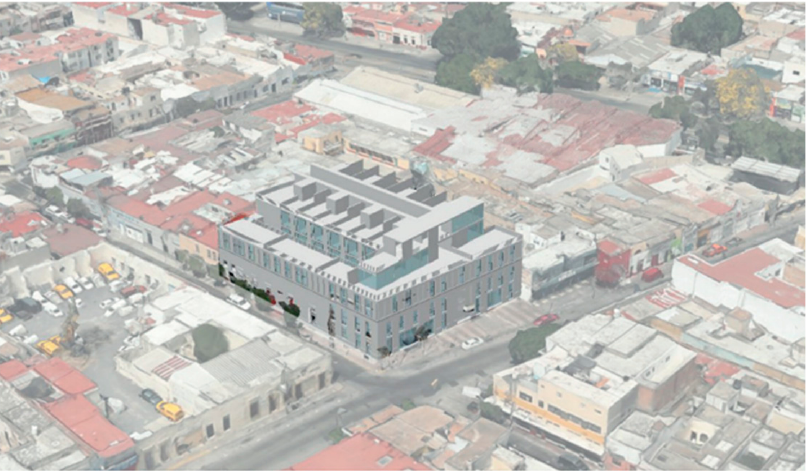
Figure 10. Example of good integration with the urban surroundings in study case number 5 “Bitloft”. Source own elaboration.